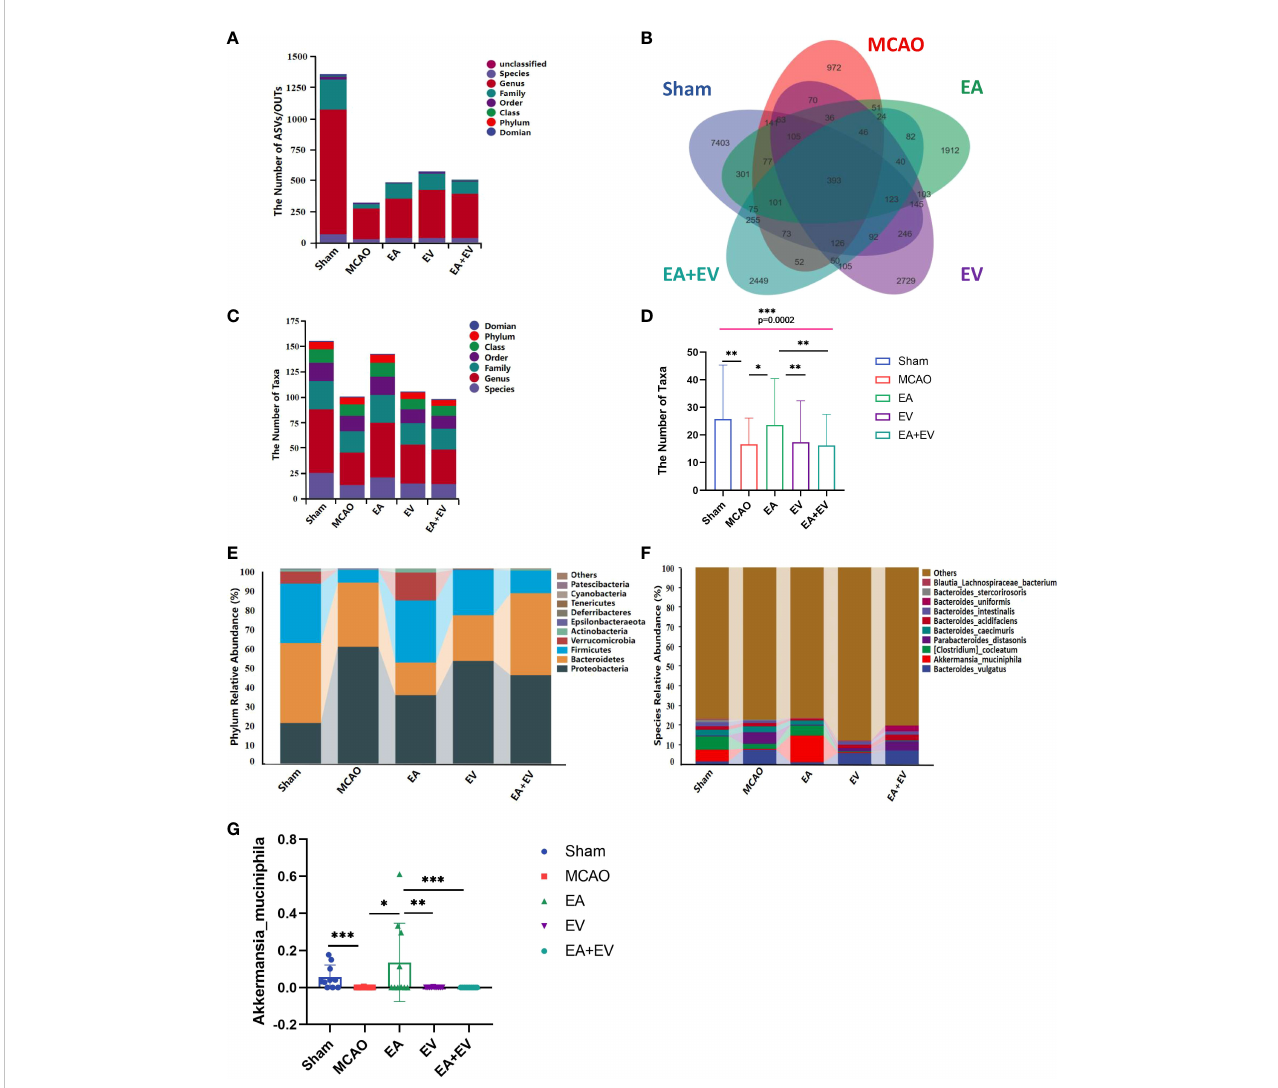
FIGURE 4 EA and iPSC-EVs treatments modulated microbiota composition after cerebral ischemia − reperfusion. (A) The ASV/OTU number at each taxonomic level of phylum, class, order, family, genus, and species. The process used for species annotation involves comparing the data with a reference sequence database and scoring the results. (B) ASV/OTU Wayne diagram. To determine which species were common and which were unique among different samples (groups), ASV/OTU abundance tables were used to generate a Venn diagram. (C, D) Species composition taxon number statistics. (E, F) Taxonomic composition statistics at the phylum and species levels. (G) Akkermansia muciniphila fl ora abundance, n=10/group, data wre expressed as the mean±SD, * P <0.05, ** P <0.01, and *** P